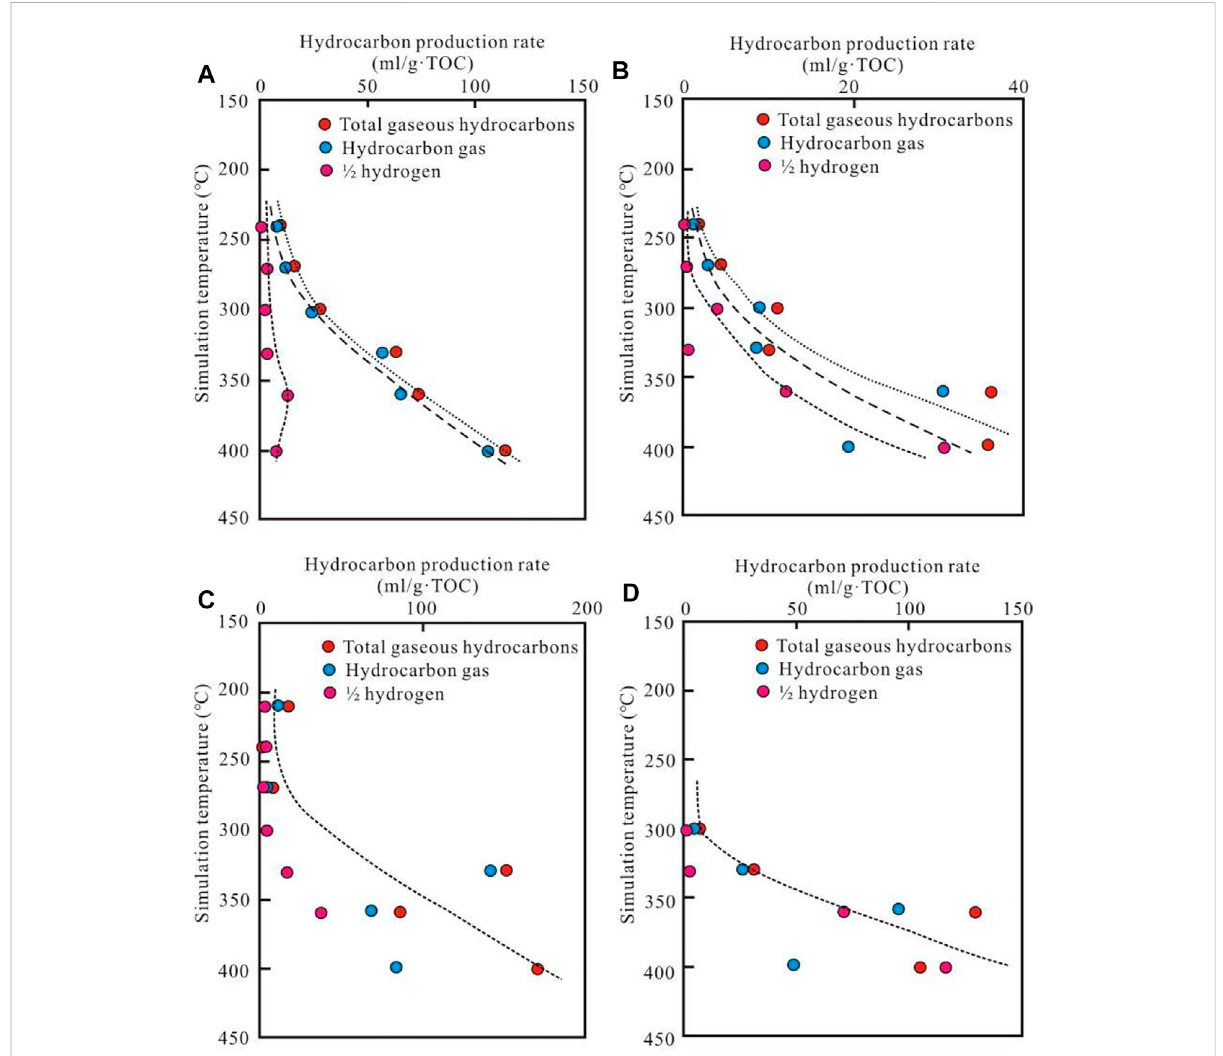
FIGURE 9 Test results of gaseous hydrocarbon yields from thermal pressure simulations of coal rocks, carbonaceous mudstones, and coal-measure mudstones in the study area in the Middle and Lower Jurassic. Notes: (A) Hua ’ an Coal Mine, coal; (B) Well Yan 2, carbonaceous mudstone; (C) Well Ma 1, dark gray mudstone; (D) Well Yannan 1, dark gray